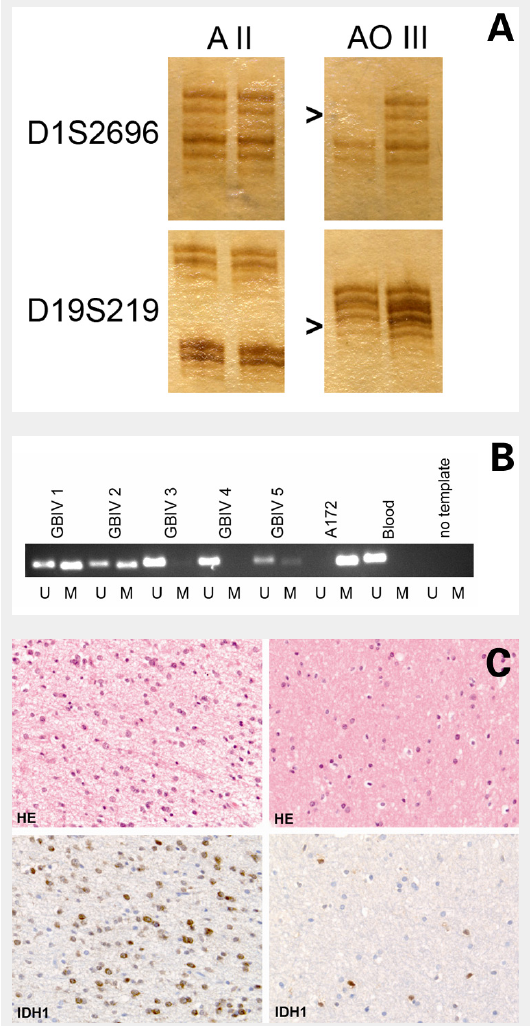
Molecular markers in malignant glioma. A: 1p/19q codeletion. Microsatellite-PCR-based analysis of allelic losses of 1p and 19q in an astrocytoma (WHO grade II) (A II) and an anaplastic oligodendroglioma (WHO grade III) (AO III). Losses of both markers are indicated by arrowheads in AO III, but not A II. B: MGMT promoter methylation. Methylation-specific PCR for unmethylated (U) and methylated (M) promoter sequences in 5 glioblastoma samples, including the glioblastoma cell line A172 as a positive control for methylated and peripheral blood cells as a control for unmethylated promoter sequences, as well as water as a negative control. C: IDH mutation. Grade II oligoastrocytoma, upper panels: HE staining, lower panels: IDH immunostaining, left panels: tumour centre, right panels: infiltration zone (Courtesy: J. Felsberg,